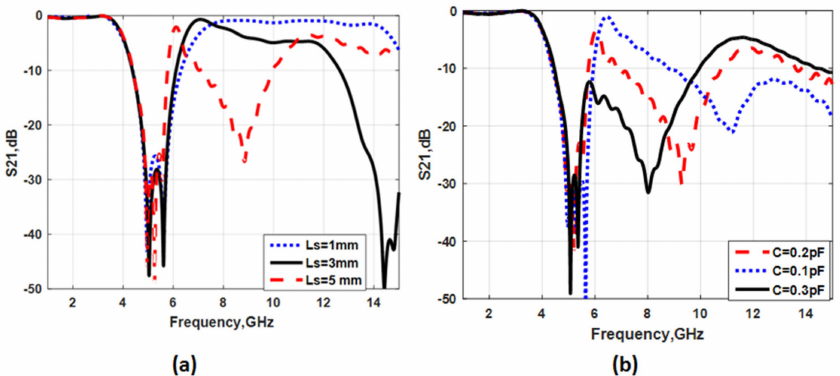
Figure 4. The insertion loss results of the OLR stub ( a ) at di ff erent values of the stub lengths (Ls) ( b ) at di ff erent values of lumped capacitors